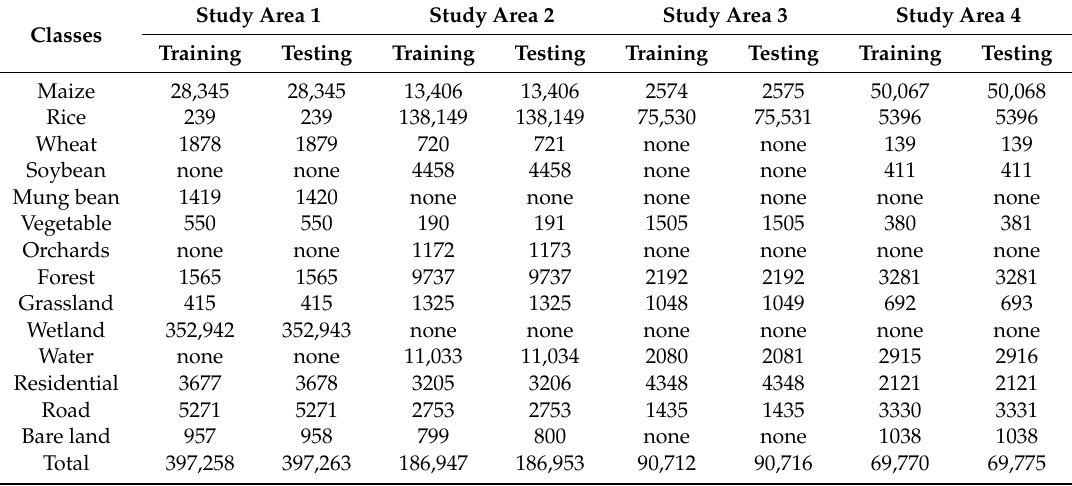
Table 3. Number of training and testing 2 m pixel samples in four study areas. The samples were derived by systematically sampling from the reference land cover maps (Figure 3) and randomly split into training and